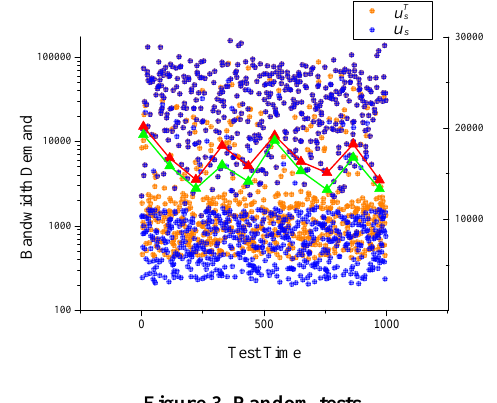
Figure 3. Random